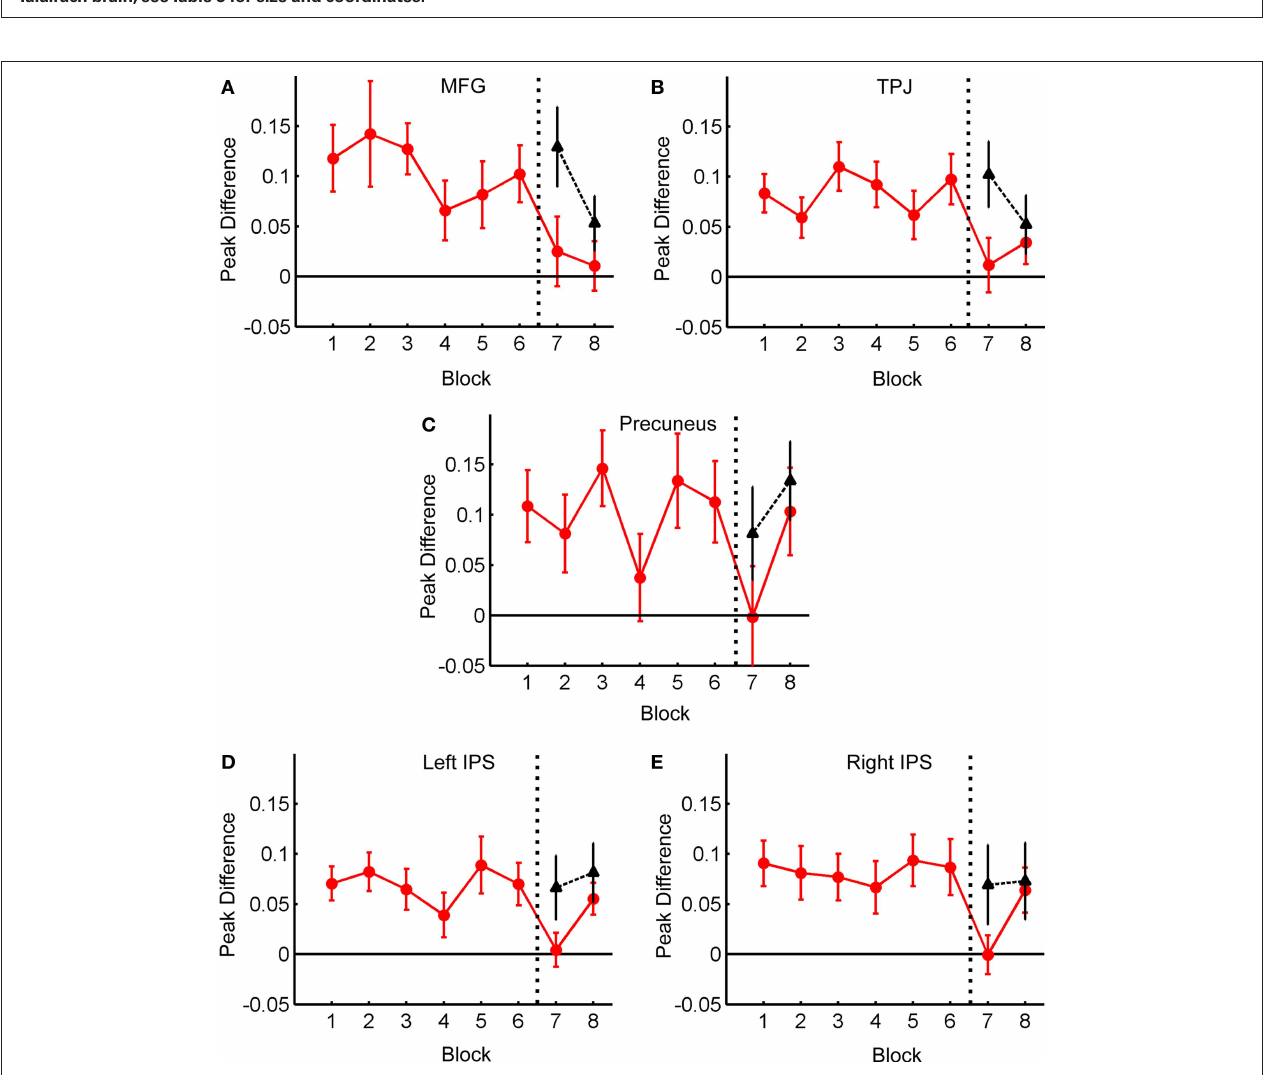
FIguRe 8 | Difference in BOLD response for Distractor Present vs. Distractor Absent trials as a function of Block. Red line: old distractor locations; black line: new distractor locations. Data for the plots extracted from the following regions: Left MFG (A) ; Right TPJ (B) ; Precuneus (C) ; Left IPS (D) ; Right IPS (e)